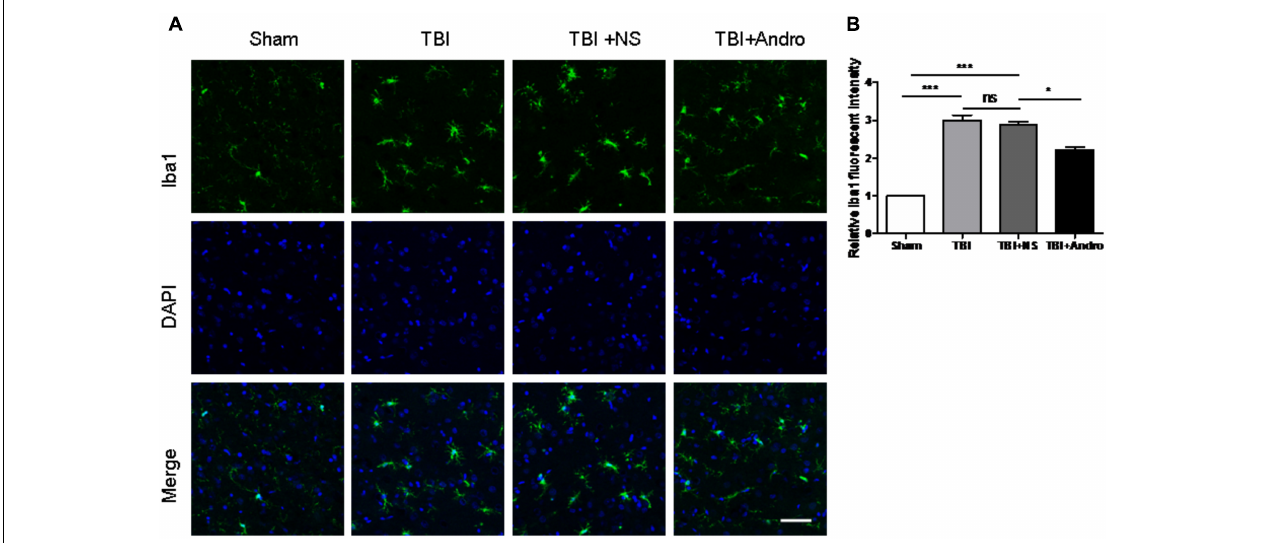
FIGURE 3 | Andro treatment inhibited microglia activation after TBI. (A) Double staining for Iba1 (green) and 4, 6-diamino-2-phenylindole (DAPI, blue) in peri-contusive cortex at 24 h after TBI. Microglia cells were highly ramified, exhibited long branching processes and a small cellular body in the sham group. In response to brain injury, the branches of microglia become short, retracted and thick. In Andro treatment group, microglia showed a smaller cellular body. Scale Bars = 50 µ m. (B) The relative fluorescent intensity of Iba1. Data are presented as the mean ± SD. ∗ p < 0.05, ∗∗ p < 0.01 ∗∗∗ p < 0.001, ns p > 0.05; n = 6 in each group.